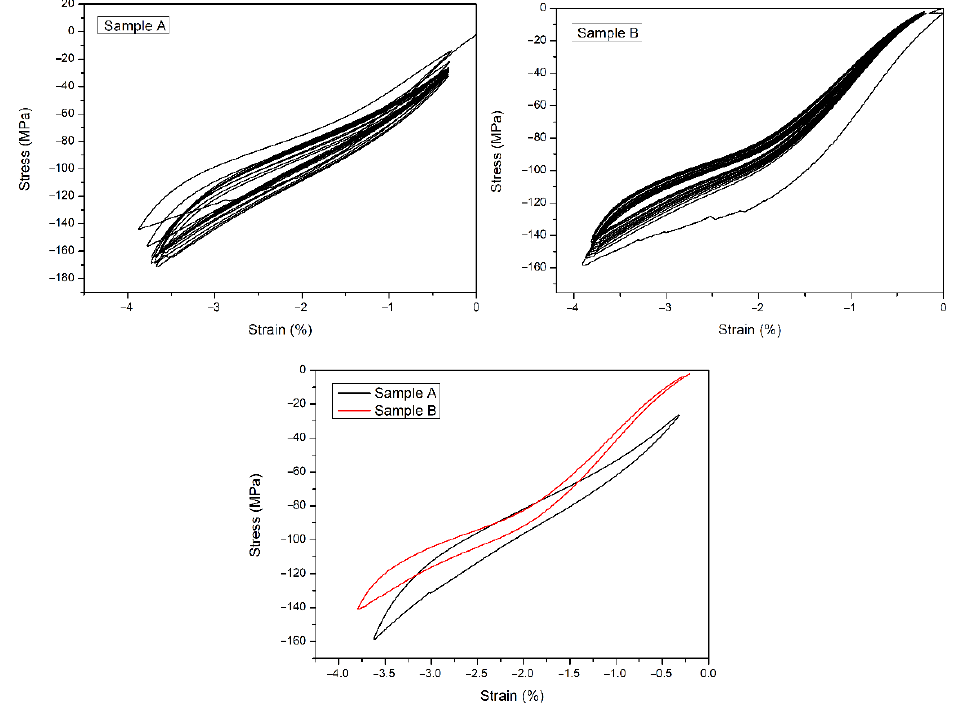
Figure 5. Stress–strain curves at 353 K for COP evaluation.